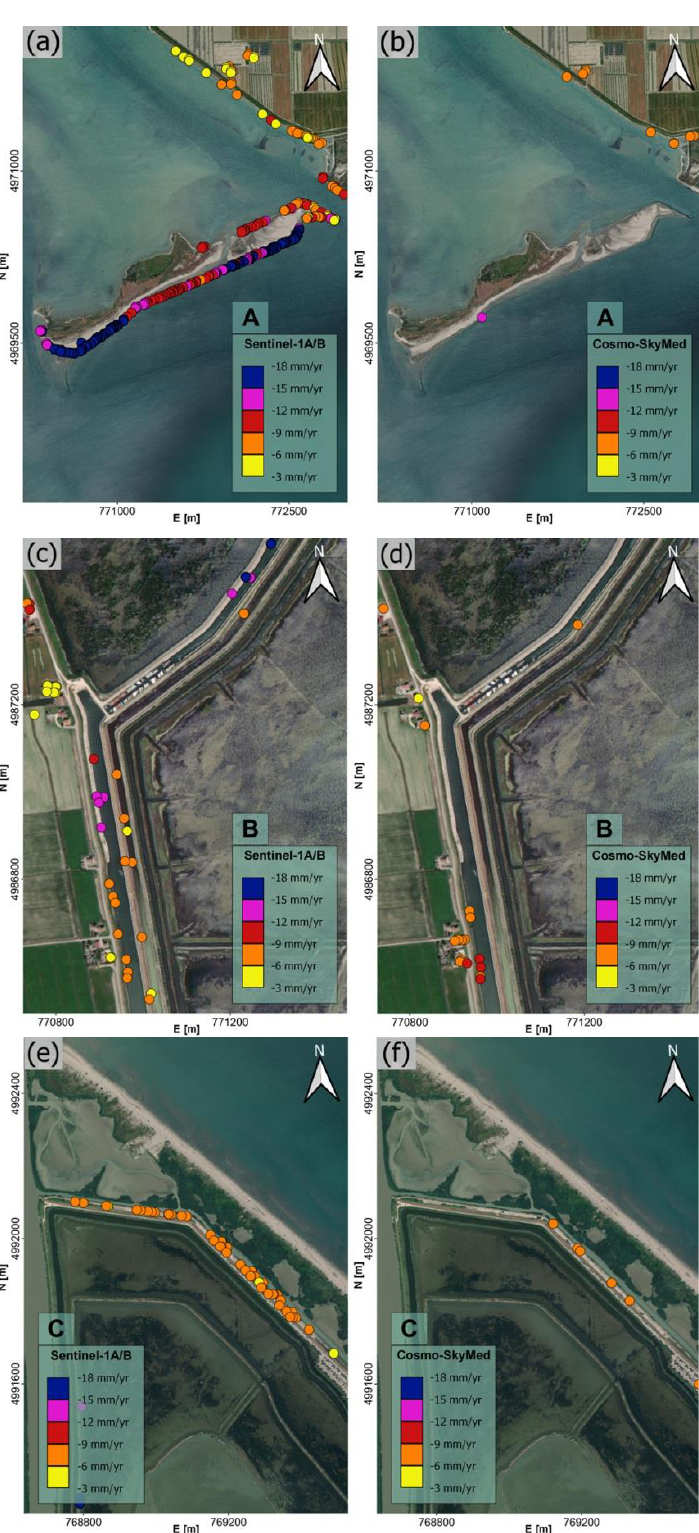
Figure 8. Kinematic pattern of the LOS velocities in the study area: ( a ) GNSS and Sentinel- 1 points; ( b ) GNSS and CSK points. The A, B, and C areas are shown in detail in Figure 9.